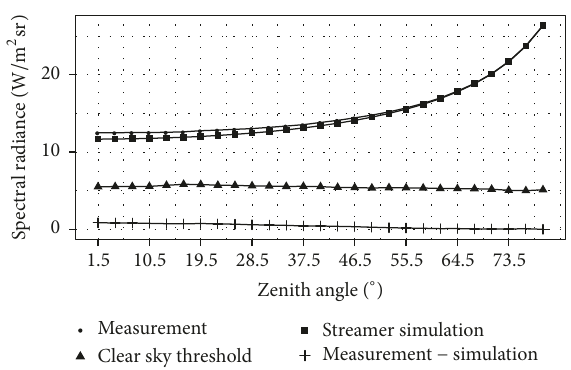
Figure 4: Measured (NubiScope) versus modelled (Streamer) radiance for different zenith angles for 16 June 2010, 09:50 UTC (residuum = measurement – simulation; cloudless sky threshold = residual radiance + 2 standard